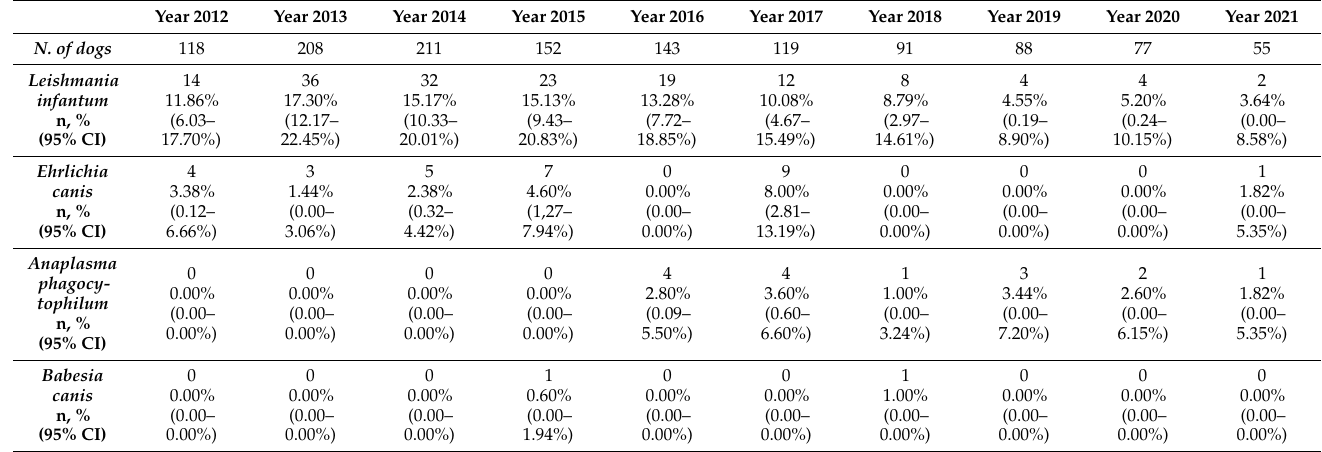
Table 2. Trend of CVBPs rates over a decade of blood bank activities